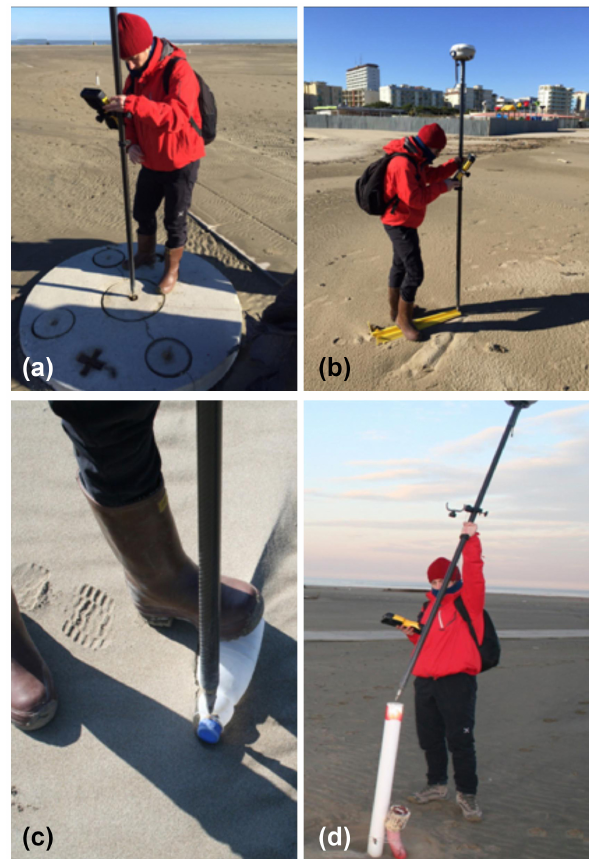
Figure 10. Photos (a) and (b) at the top demonstrate practical GCPs based on unique shapes, colours, and the ability to see from a high altitude. Photos (c) and (d) , on the bottom, demonstrate error- inducing GCPs due to their height off the ground and indistinguish- able shape, size, and colour in aerial